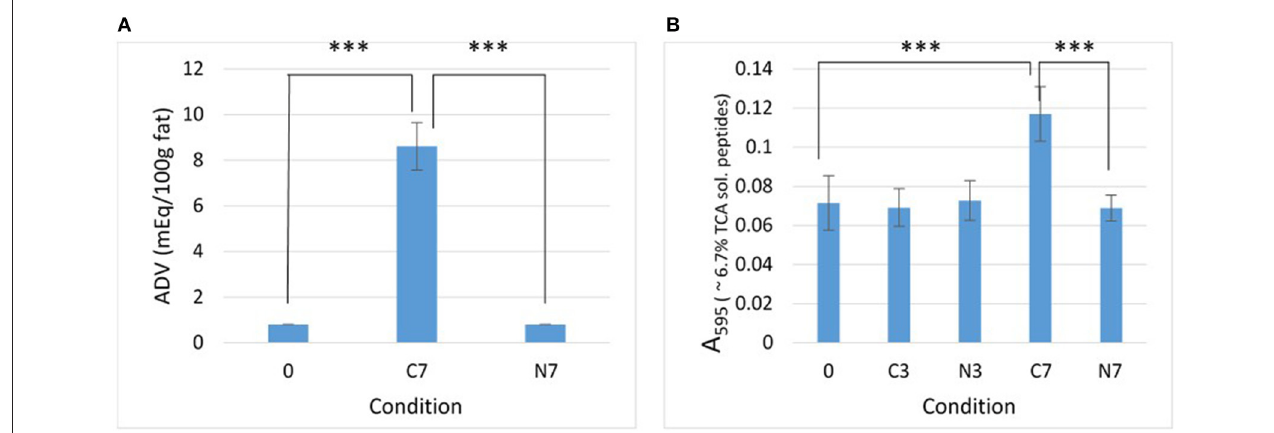
FIGURE 1 | Lipolysis and proteolysis. Effect of the N 2 gas-flushing on (A) lipolysis and (B) proteolysis, in the three raw-milk samples (M1–M3) at initial stage (0) and after cold-storage for 3 and 7 days at 6 ◦ C in the presence (N3, N7) or absence (C3, C7) of N 2 gas-flushing. In (A) , each data point represents the mean ADV value obtained from the three samples. In (B) , data points correspond to the mean values obtained from three replicates for each raw-milk sample.